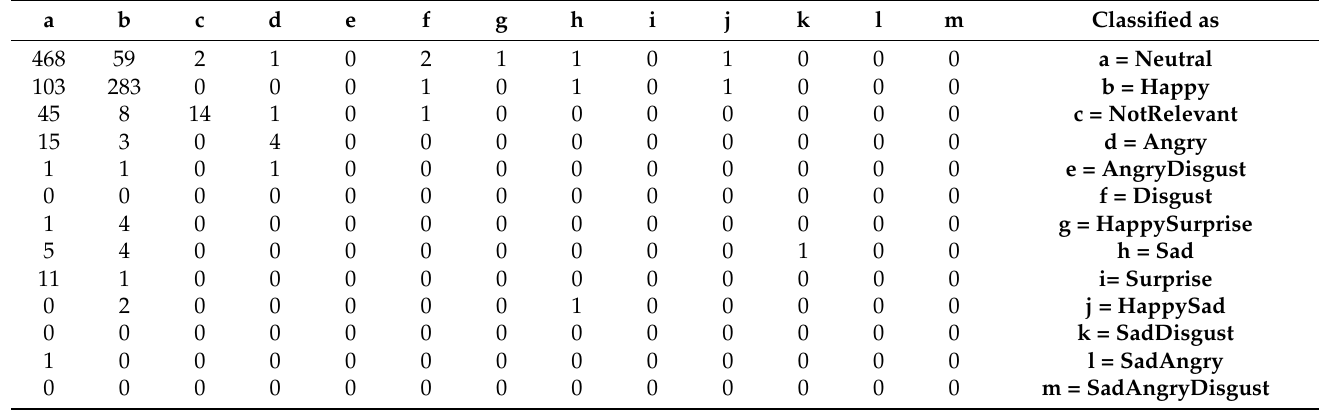
Table 5 represents the confusion matrix by class using a single feature selection tech- nique in combination with LL, and its graphical representation is shown in Figure 7. Table 5. Confusion matrix by class (single feature selection technique).